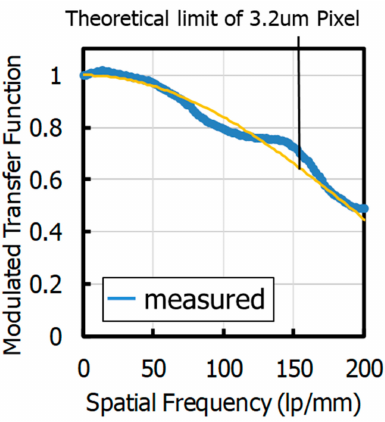
Figure 21. Spatial frequency dependency of MTF of a 3.2 µ m pitch GS pixel with a light pipe and stacked deep